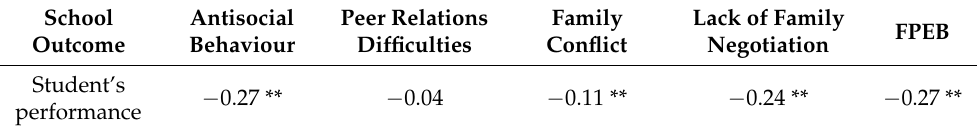
Table 4. Correlations among students’ performance and the Family, Peers, and Externalising Be- haviour (FPEB) factors and total